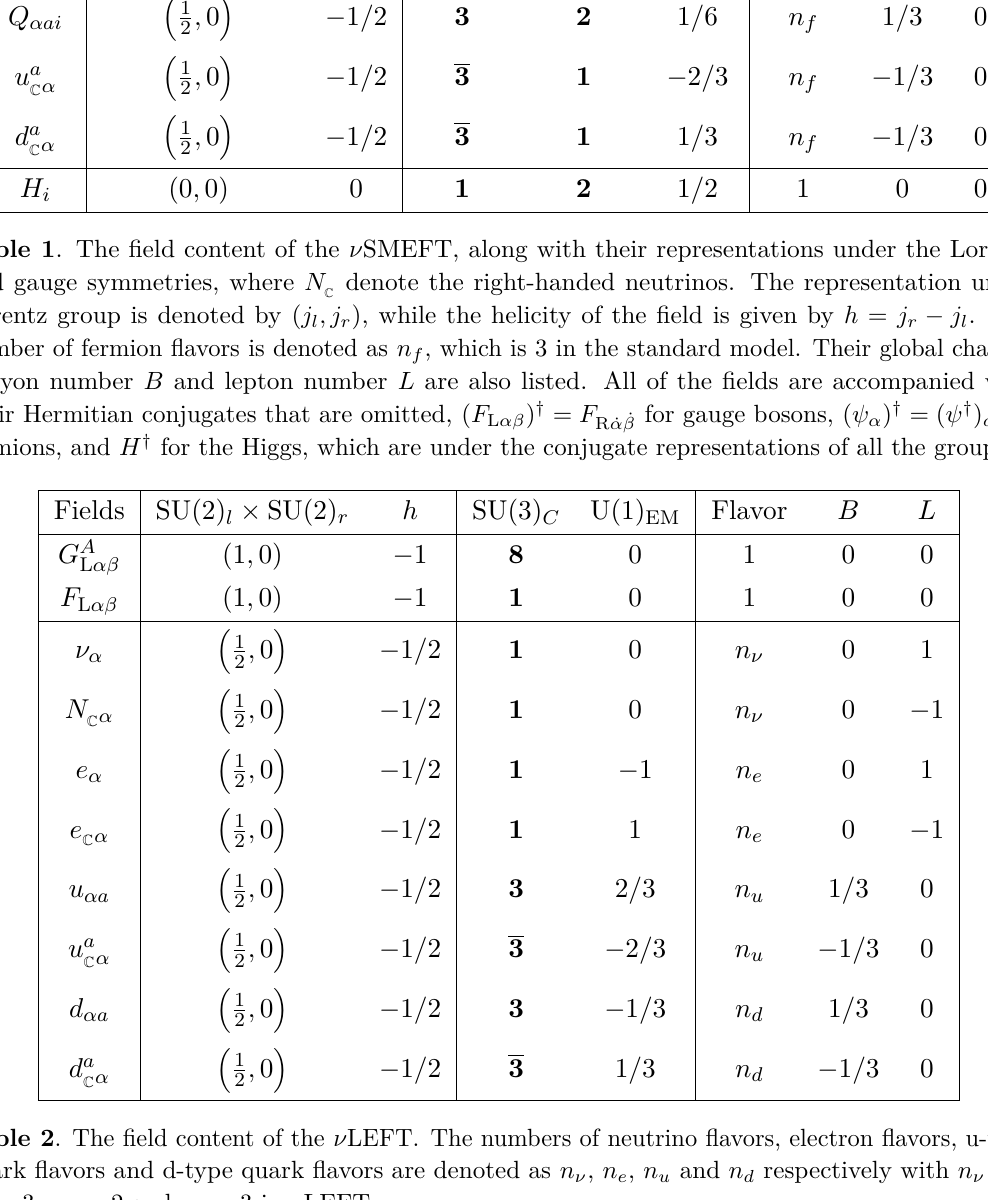
, n , n and n respectively with n ν e u d